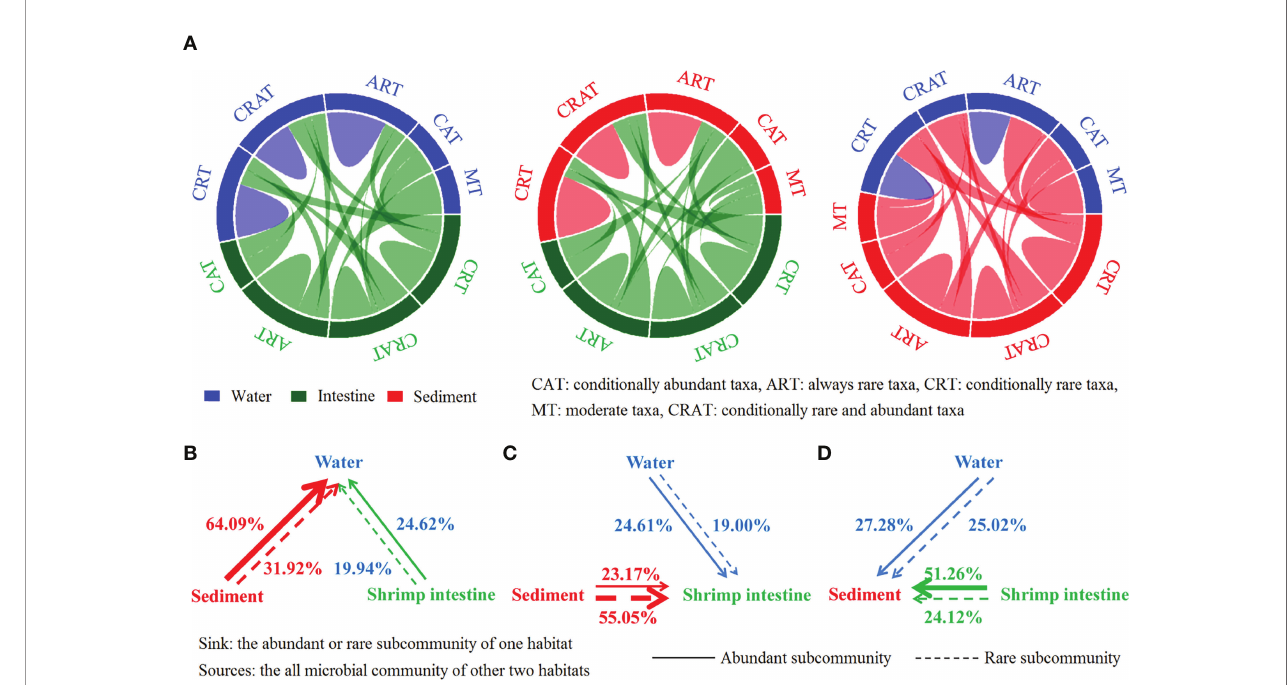
FIGURE 1 | Relationship among communities of three habitats. (A) The Chord Diagram analysis showed that the close relationships among abundant and/or rare communities among water, shrimp intestine and sediment habitats. (B – D) The FEAST analysis results of the contributions of whole communities in water, intestine and sediment to each other ’ s abundant community or rare community.